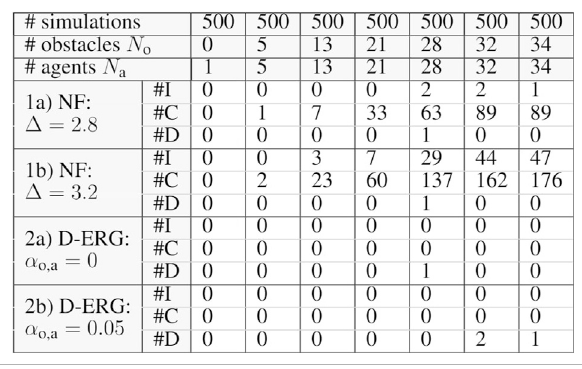
Frontiers in Robotics and AI |